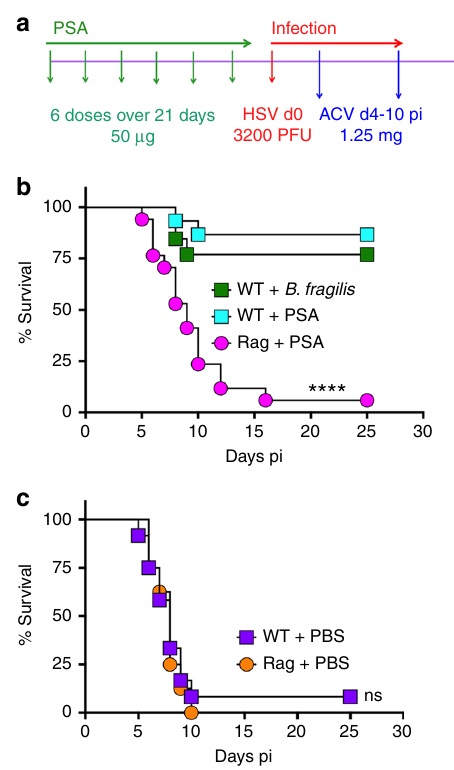
Fig. 1 B. fragilis PSA protects against HSE. a Experimental regimen: In all experiments, PSA (six doses, 50 μ g/mouse) or PBS was given orally before HSV infection on day 0 and thereafter daily ip injections of ACV from day 4 pi for 7 days. Survival of wildtype (WT) or Rag mice pre-treated with b B. fragilis , PSA or c PBS, ( n = 8 – 17 mice/group). **** p < 0.001, WT + B. fragilis /PSA vs. Rag + PSA; ns: not signi fi cant, WT + PBS vs. Rag +